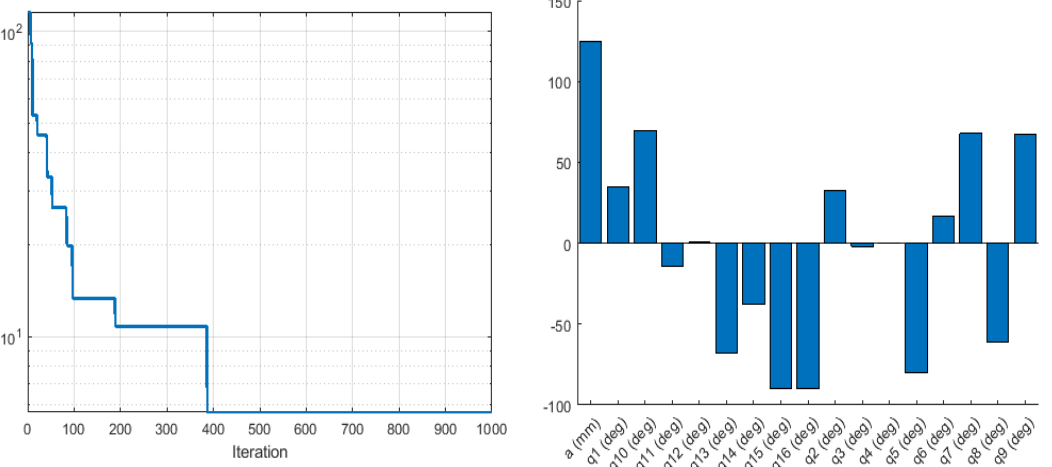
Figure 9. Objective function values ( left ), and the corresponding optimised joint parameters ( right ) for the best objective function value obtained by Fmincon for the IK optimisations.